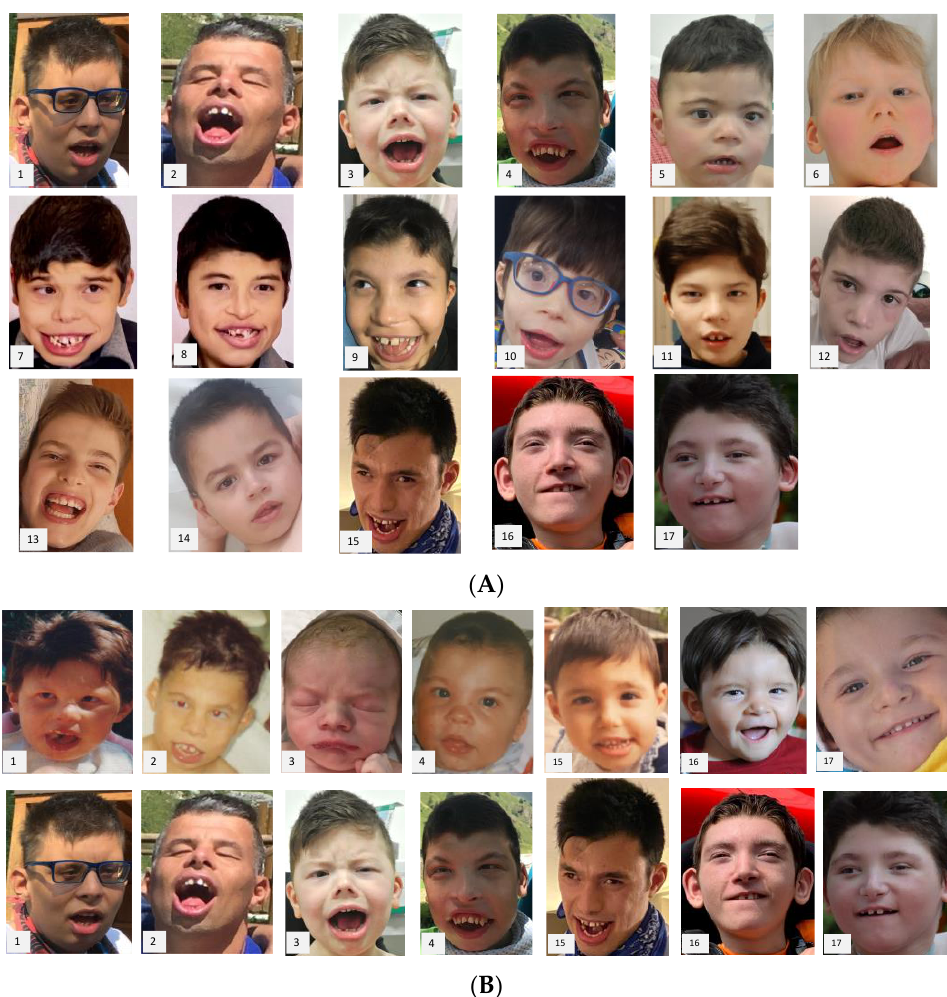
Figure 1. Facial aspect of patients. For molecular matches, the number refers to patients ID reported in Table 1. ( A ) Pictures of all patients at current age. ( B ) Where available, pictures of patients at younger (top) and current ages (bottom).